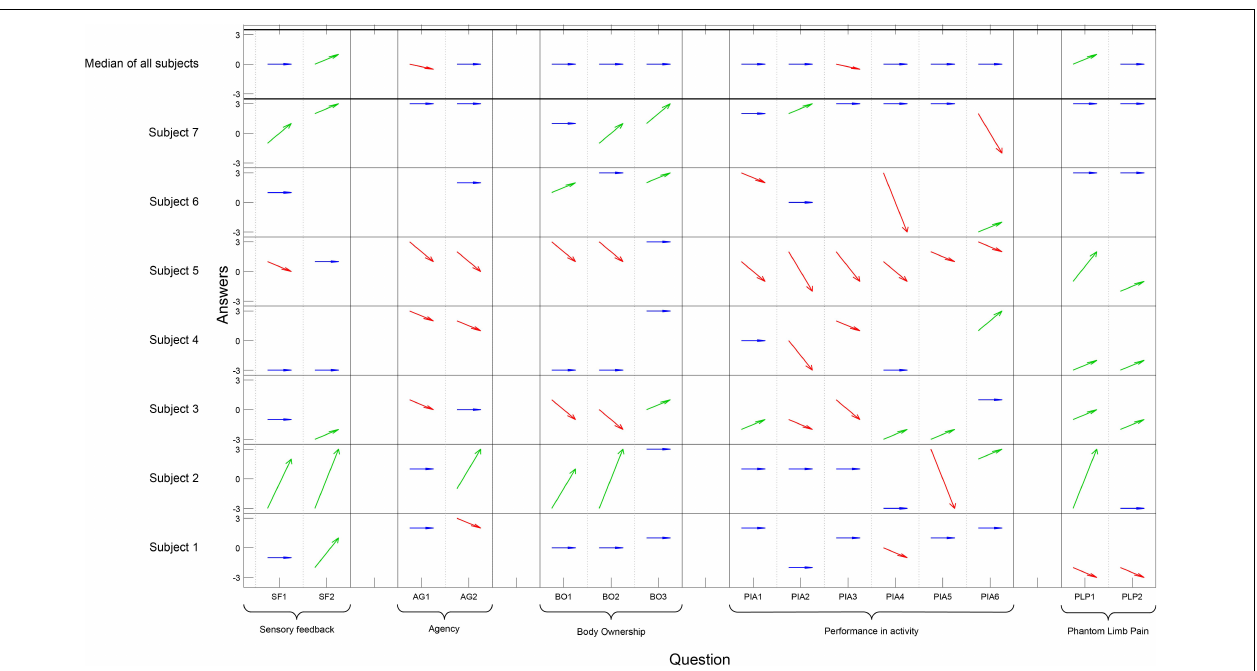
FIGURE 3 | On the x -axis each question has a column and the questions are grouped according to concept. The y -axis presents each participant and the Likert scale. The answers pre- and post- are illustrated with an arrow for each question and participant; an improvement is illustrated by a green arrow, an impairment by a red arrow, and if there was no change the arrow is blue (Question PLP1–PLP2 for homogeneity in the table, a high value [3] indicates less pain). The six control questions are not presented in the figure. Wilcoxon signed rank test showed a significant positive change regarding Sensory feedback ( p = 0.031), a significant negative change regarding Agency ( p = 0.023), and Performance in Activity ( p = 0.007). No significant changes were seen in the other concept categories in the